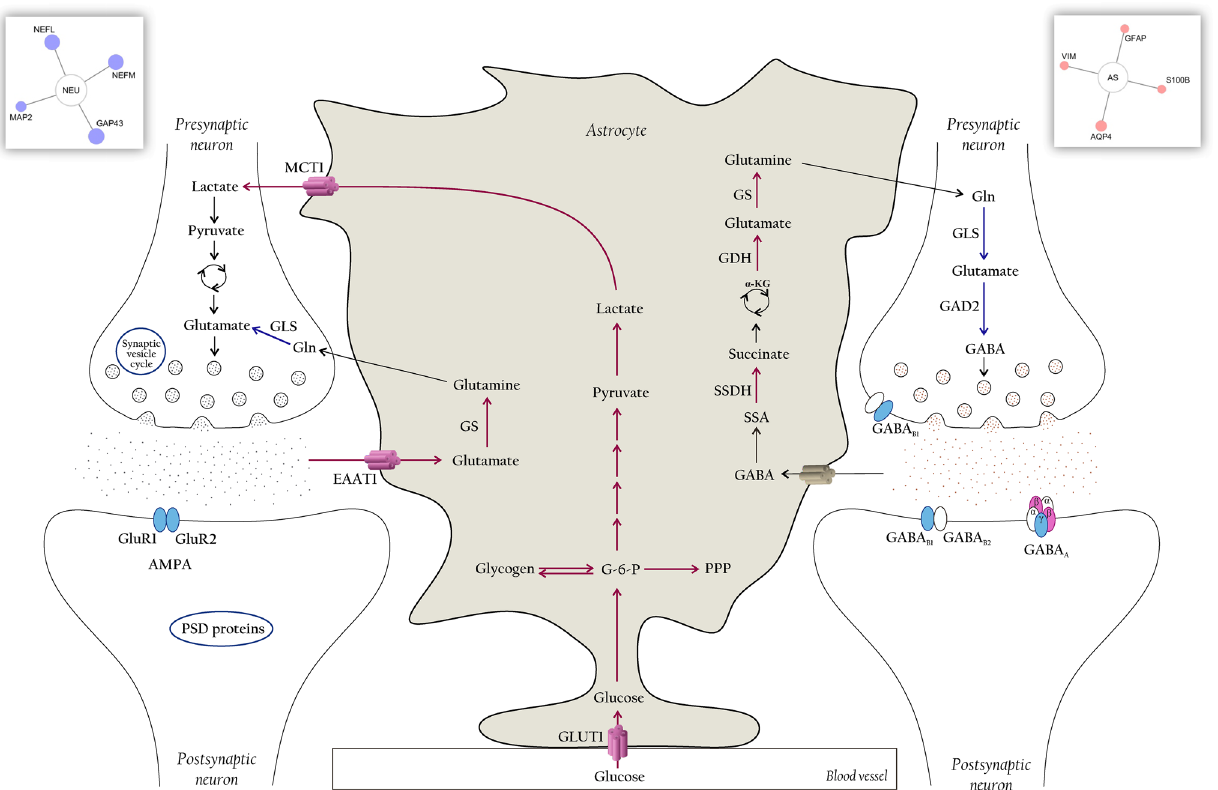
Figure 7. Influence of sex on glutamate-glutamine cycle. Schematic representation of glutamate/GABA- glutamine cycle depicting the metabolic interactions between a glutamatergic neuron, a GABAergic neuron and an astrocyte. Predominant pathways and reactions in females and males are indicated by pink and blue arrows, respectively. Increased abundant transporters and neurotransmitters subunits are evidenced by pink (females) or blue (males) colors. For more details, see Supplementary